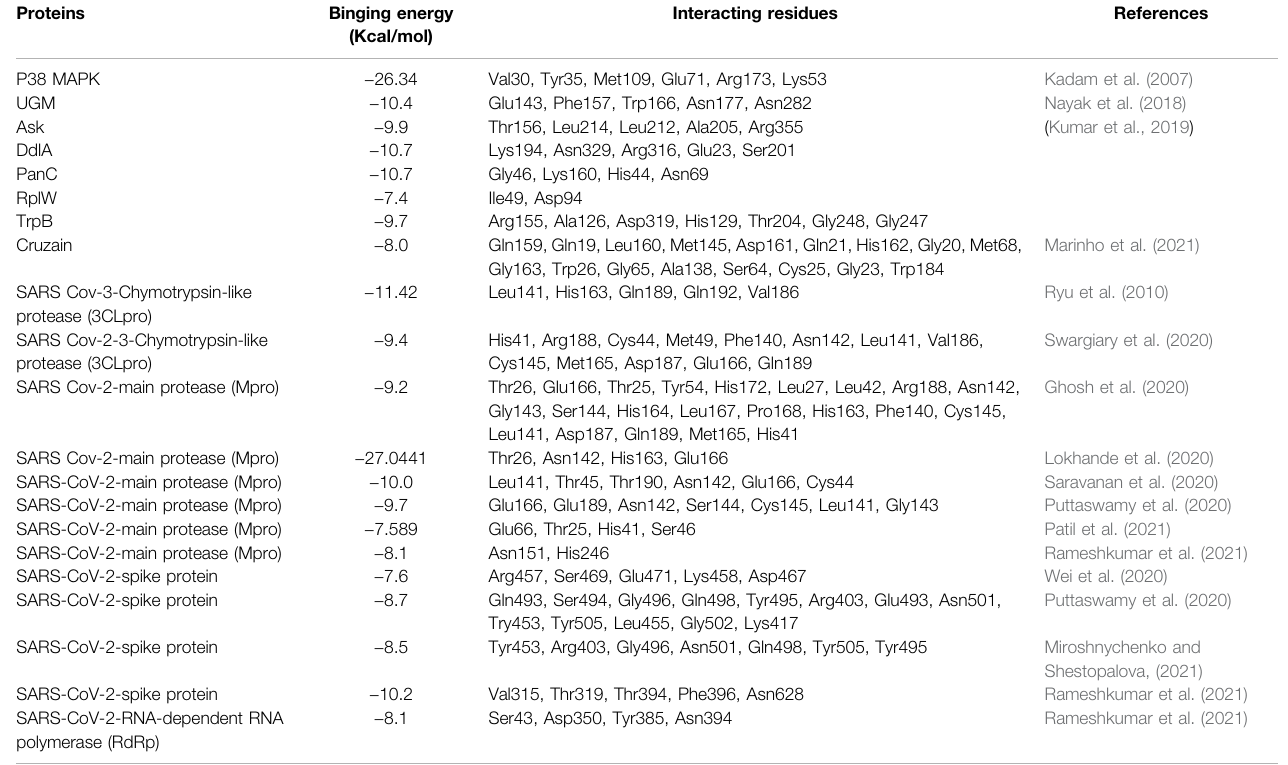
TABLE 4 | Molecular docking proteins of AMF through in silico